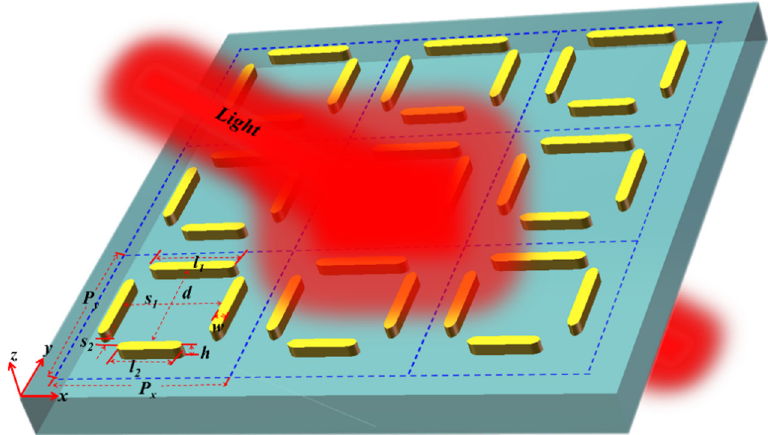
Figure 1. Periodic array diagram of rectangular-like nanotetramer metasurface structure.